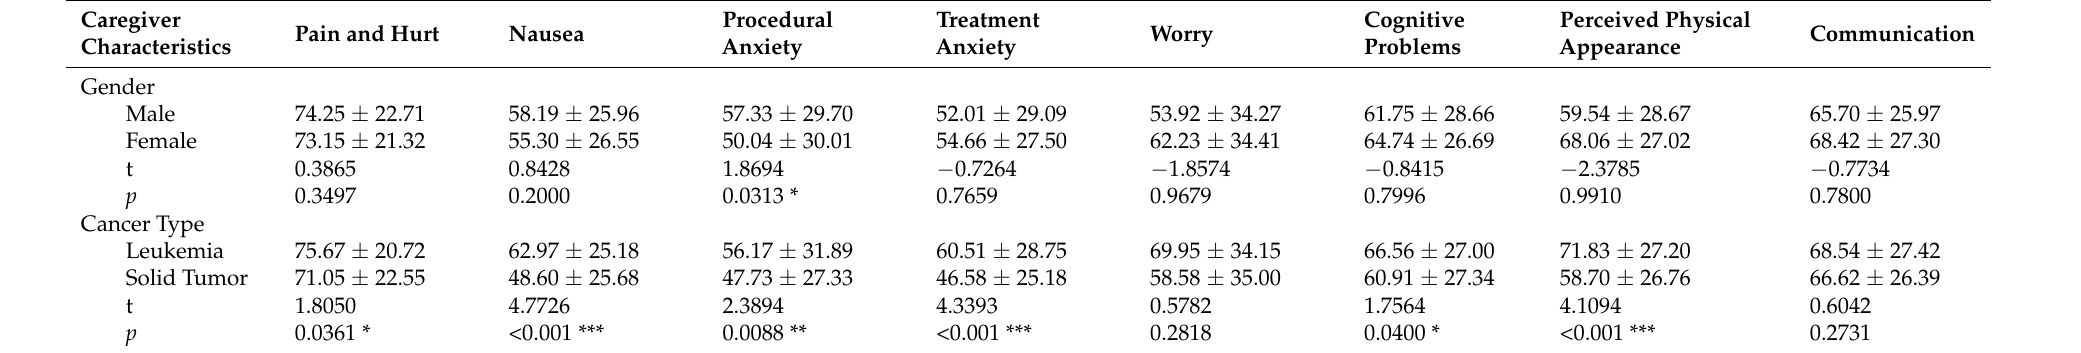
Table 2. Differences in QoL domains regarding the caregiver and cancer characteristics (N =